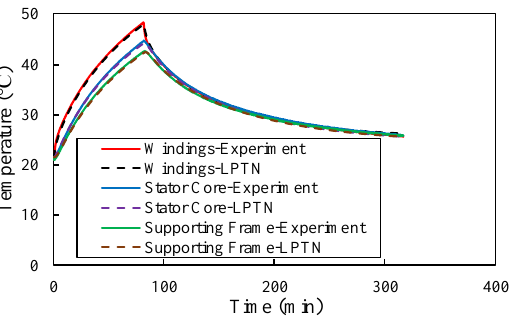
Figure 20. Instantaneous temperature-rise test of the prototype under 10 A DC.